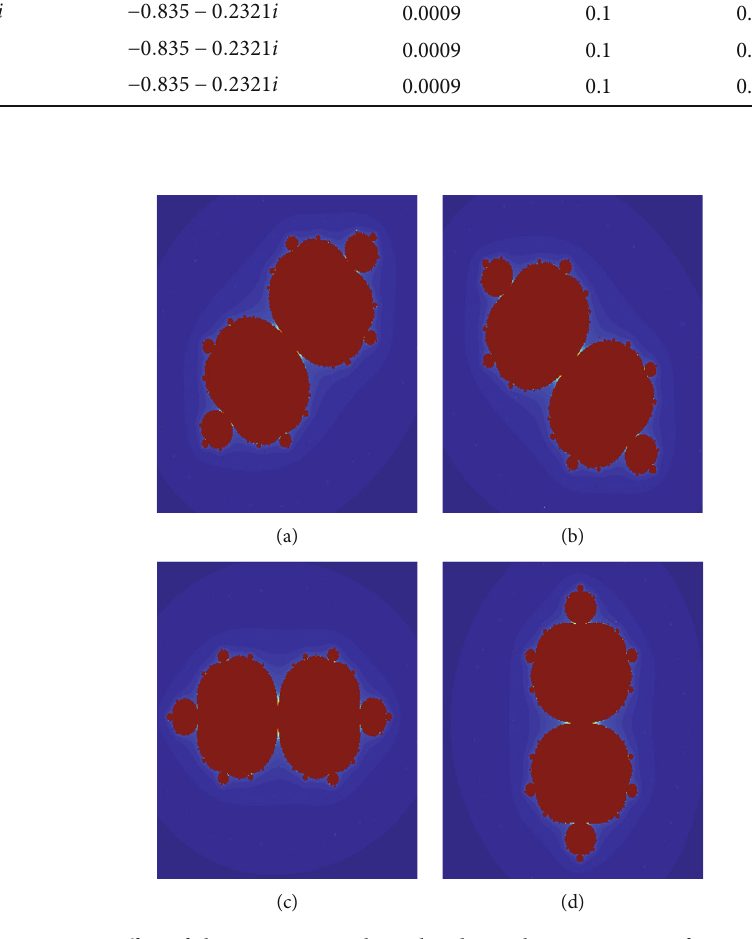
Figure 3: E ff ect of change in sign in the real and complex parameter a of quartic Julia set.